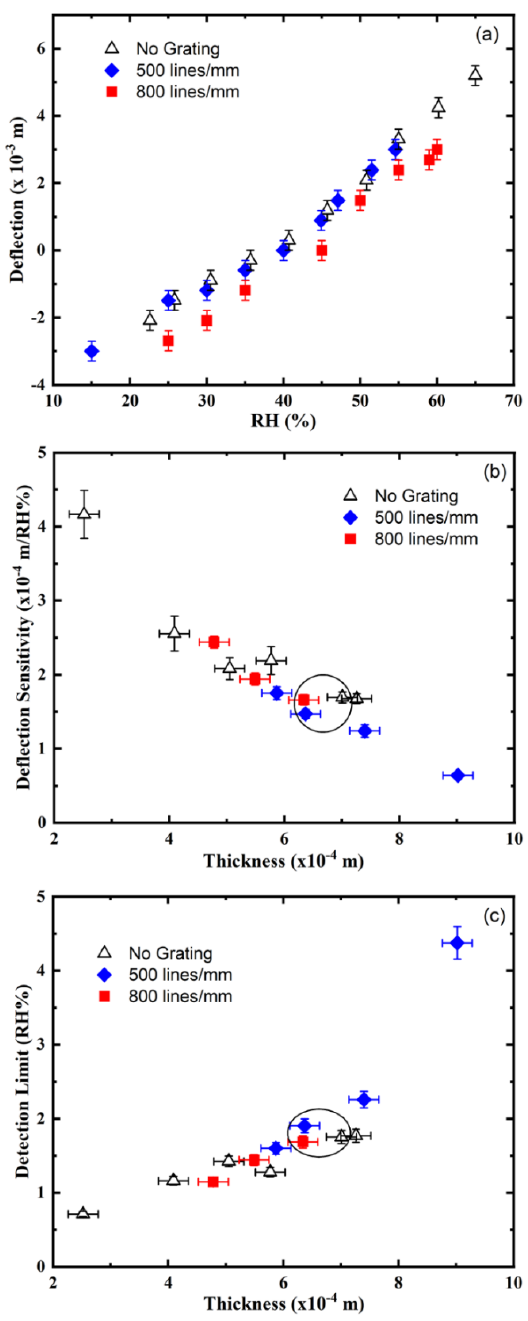
Figure 2. ( a ) Typical cantilever linear deflection as relative humidity (RH) varied for an 800 lines/mm (square), 500 lines/mm (diamond) and a no grating cantilever of similar thickness (637 µ m, 634 µ m and 701 µ m for the 800 lines/m, 500 lines/mm grating and no grating, respectively); ( b ) the deflection sensitivity and ( c ) RH detection limit for two different grating types as cantilever thickness varied. The data for no grating cantilever sensors (black triangle) are also presented. The circled data points show the 3 cantilevers in Figure 2a and the cantilevers investigated using Bragg angular selectivity curves in Figure 3.